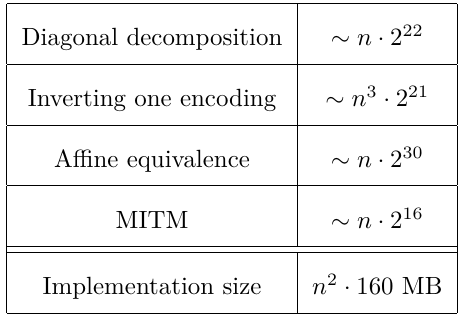
Figure 7: Complexity of our attack and implementation size for n parallel AES